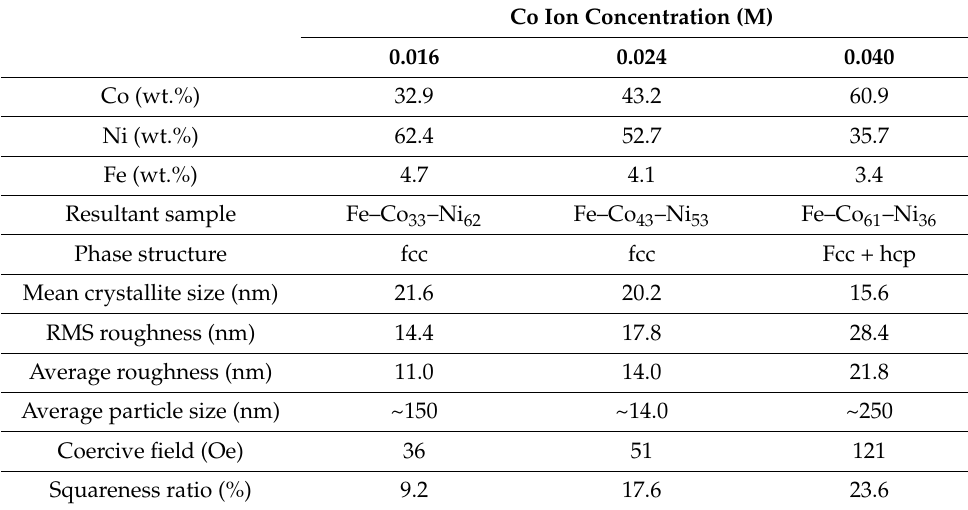
Table 1. The EDX data, phase structure, mean crystallite size, roughness parameters, coercive field, and squareness ratio of the